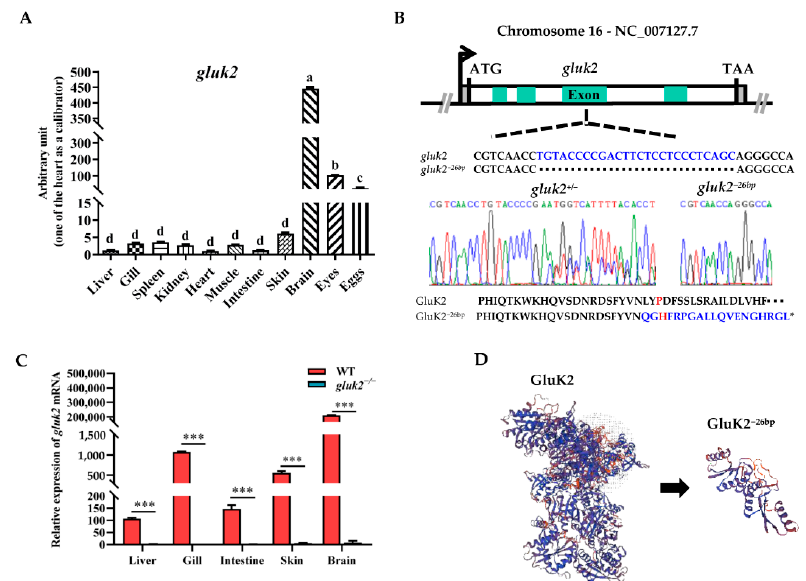
Figure 1. Distribution and knockout of the gluk2 gene in zebrafish. ( A ). The relative mRNA levels of gluk2 are determined in selected tissues of wild-type. Analysis of variance (ANOVA) and the Duncan test are applied on the data, p < 2 × 10 − 16 . a − d: The same letter indicates no difference between means as determined ( p < 0.05), different letters indicate a significant difference ( p < 0.05). ( B ). gluk2 locus, with gluk2 − 26bp mutation and a premature stop in gluk2 − 26bp . Asterisk indicates stop codon. ( C ). The relative mRNA levels of gluk2 are determined in wild-type and gluk2 − / − mutant. Values plotted are means ± SEM, *** p < 0.001, compared with control. ( D ). The predicted three-dimensional structures of GluK2 and GluK2 − 26bp